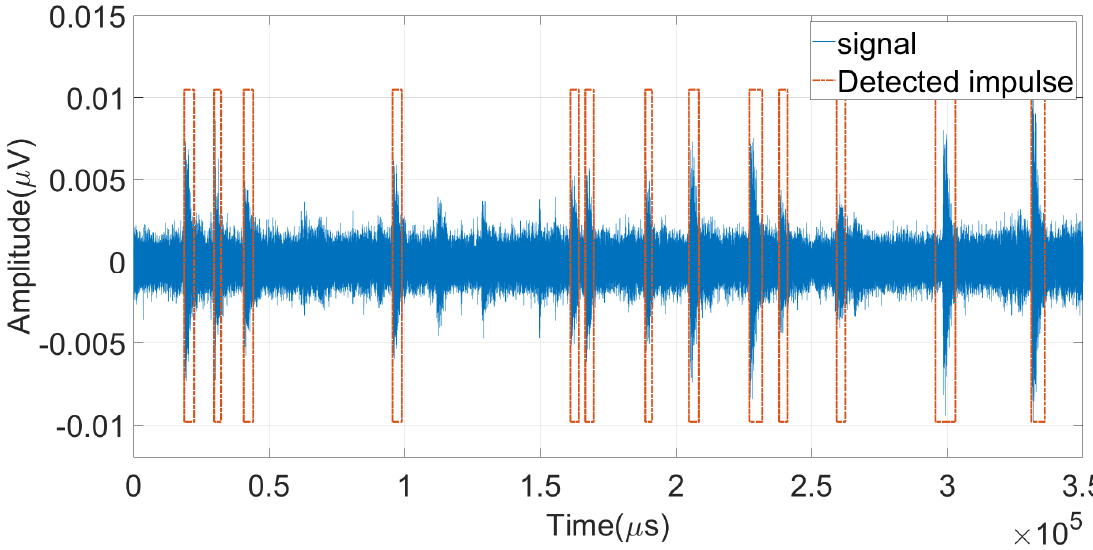
Figure 5. Performance of ECFAR burst detection algorithm when applied to the leak signal.